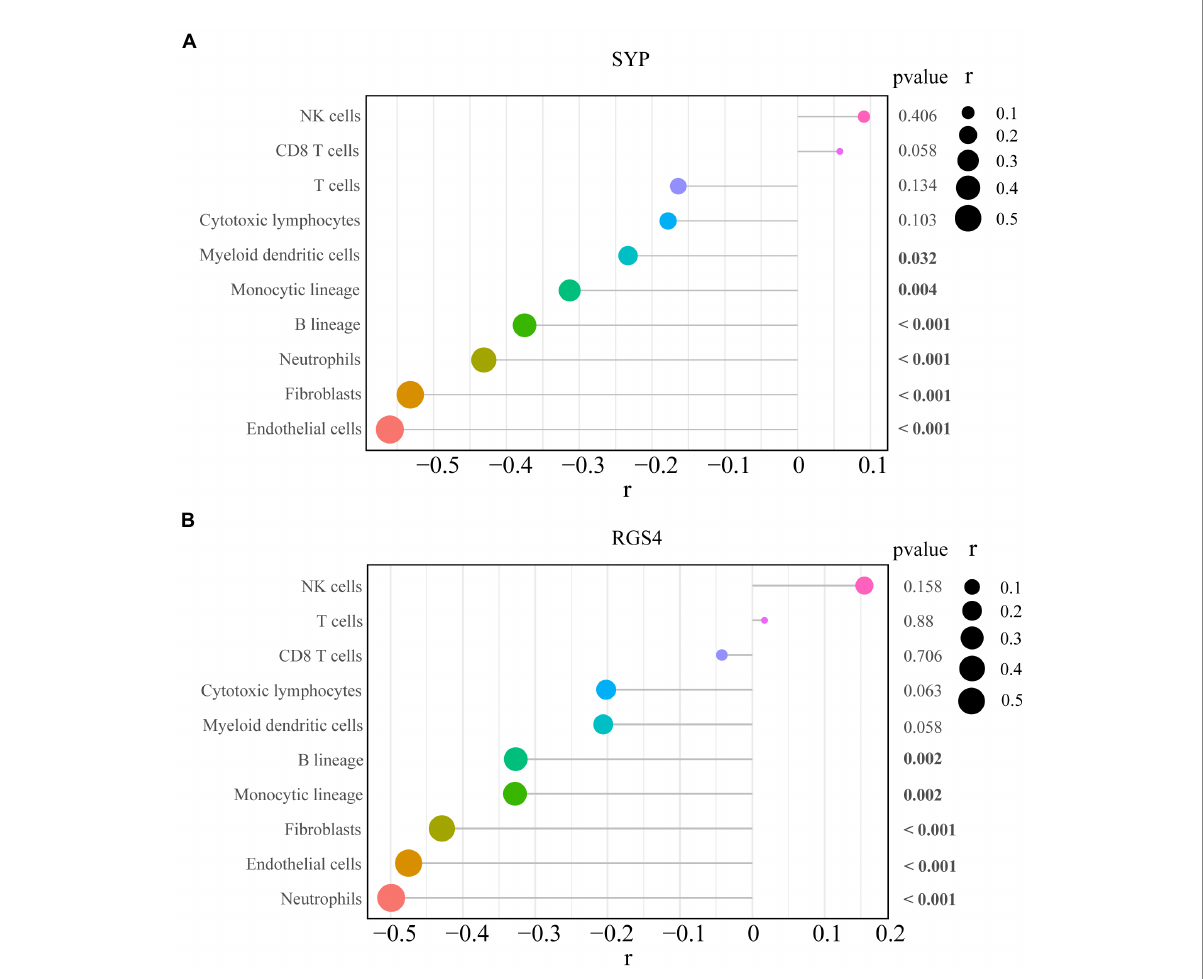
FIGURE 10 Correlation between diagnostic markers and 8 types of immune cells and 2 types of non-immune stromal cells. (A) Correlation between SYP and 10 types of cells. (B) Correlation between RGS4 and 10 types of cells. The larger dots represent the stronger correlation between genes and cells. p < 0.05 indicated statistically